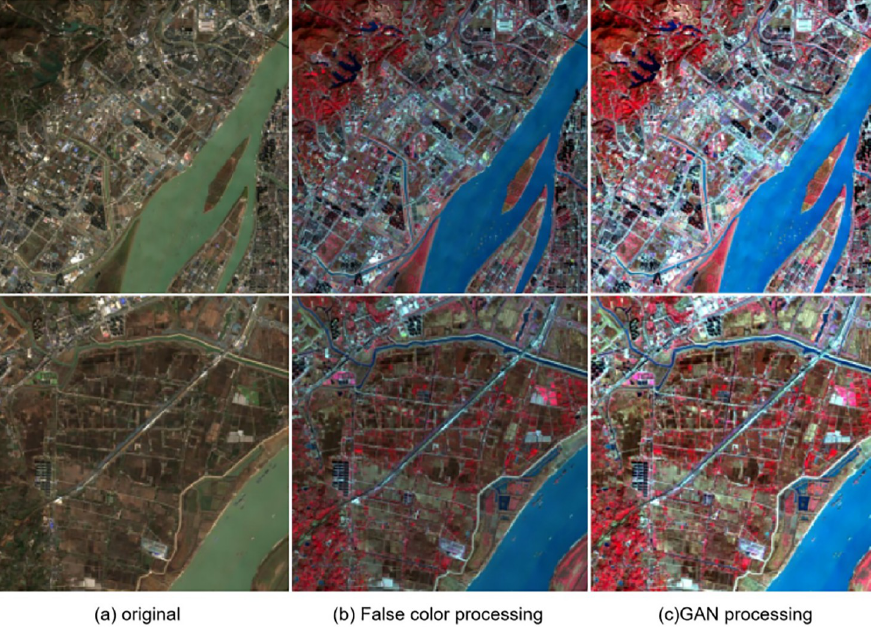
Fig 6. Comparison of false color processing and GAN processing. From left to right are the original image, the image after false color processing and the image after GAN processing. It is not difficult to see that compared with the other two kinds of data, the data processed by GAN has stronger contrast and more obvious water features. Reprinted from www.gscloud.cn under a CC BY license, with permission from Dr. Qinghui Lin, original copyright 2019.